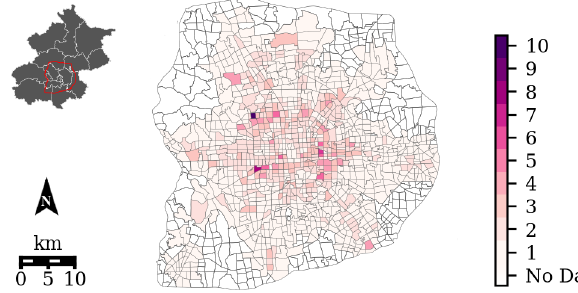
Figure 5. Overview of the case study area in Beijing, China. The color in the Choropleth represents the number of human mobility flux captured by the mobile phone signaling data. Each unit denotes 10,000 people. Each polygon covers a traffic analysis